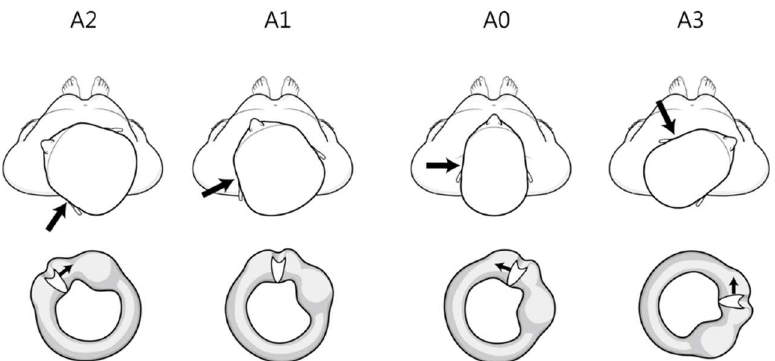
Figure 1. Theoretical findings of the position of the cupula according to the head rotation angle during the head roll test in left persistent direction-changing positional nystagmus. The large and small arrows indicate the lesion side and direction of cupula movement, respectively. The left horizontal canal and cupula viewed from the front. A0 (supine position) cupula medial to lateral position. A1 (null plane) rotated 20–30 ◦ to the left (lesion side). Cupula parallel to the vertical axis. A2 (head turning to the left, lesion side) rotated an additional 40–50 ◦ . Cupula 40–50 ◦ downward from the vertical axis. A3 (head turning to the right, opposite side of the lesion) Cupula 90–100 ◦ to the vertical axis. ◦ In patients with DCPN with a null plane, at 90 rotation from the null plane, both vertigo